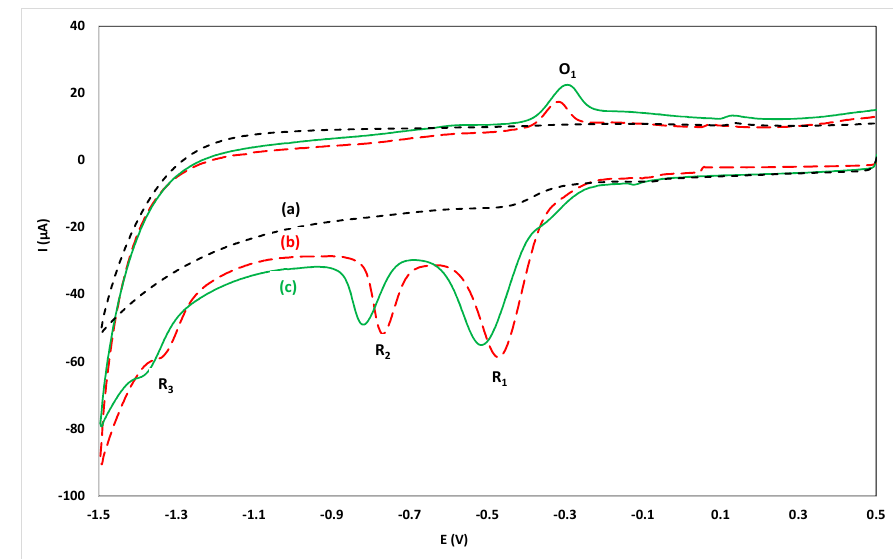
Figure 2. Cyclic voltammograms in the range 0.50 V to − 1.50 V: ( a ) immersing the sensor in an aqueous solution of 0.08 mol L − 1 KCl; ( b ) as ( a ) after addition of 15.7 mg L − 1 flunitrazepam; ( c ) at a 50 µL drop of an aqueous solution containing 15.7 mg L − 1 flunitrazepam at the sensor modified with dry KCl (1 µL drop of 4.0 mol L − 1 KCl).